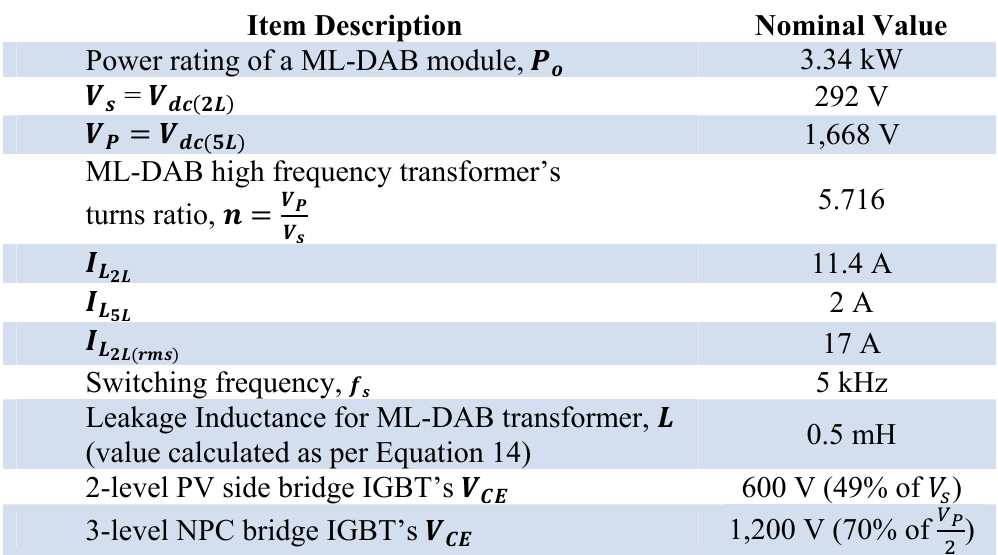
Table 2. Parameter values for a 3.34-kW ML-DAB based on the 2L-5L topology.